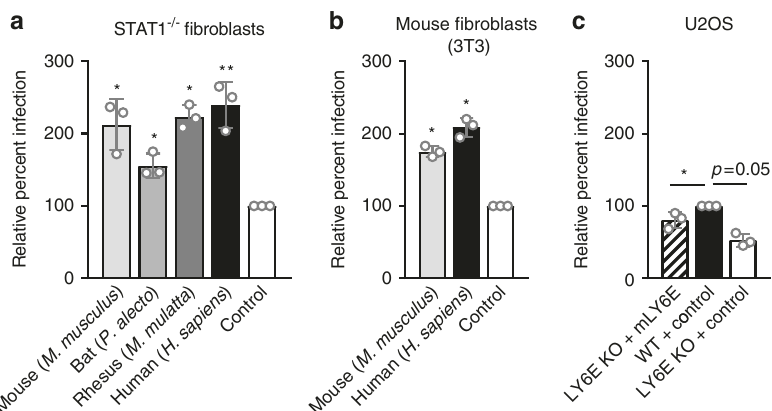
Fig. 6 LY6E-mediated viral enhancement is conserved across mammalian species. a STAT1 -/- fi broblasts transduced with lentivirus expressing human, rhesus, bat, or mouse LY6E orthologs or an empty vector control were infected with YFV-17D-Venus (0.25 MOI, 24 h, control average 13.1% infection). Percent infection was quanti fi ed by fl ow cytometry and is shown normalized to infection of control cells. n = 3 biological replicates. b Mouse fi broblasts (3T3) transduced with lentivirus expressing human LY6E, mouse Ly6e, or empty vector control were infected with YFV-17D-Venus (1 MOI, 24 h, control average 5.5% infection). Percent infection was quanti fi ed by fl ow cytometry and is shown normalized to infection of control cells. n = 3 biological replicates. c LY6E KO and WT U2OS transduced with lentivirus expressing mouse Ly6e or empty vector control were infected with YFV-17D-Venus (0.6 MOI, 24 h, control average 51.8% infection). Percent infection was quanti fi ed by fl ow cytometry and is shown normalized to infection of WT U2OS transduced with empty vector. n = 3 biological replicates. * p < 0.05, ** p < 0.01. SD is shown. Statistical analyses were performed before data normalization using repeated measures one-way ANOVA, with the Greenhouse-Geisser correction and Dunnett ’ s multiple comparisons test. Comparisons are relative to control for ( a , b ) and relative to WT + control for ( c